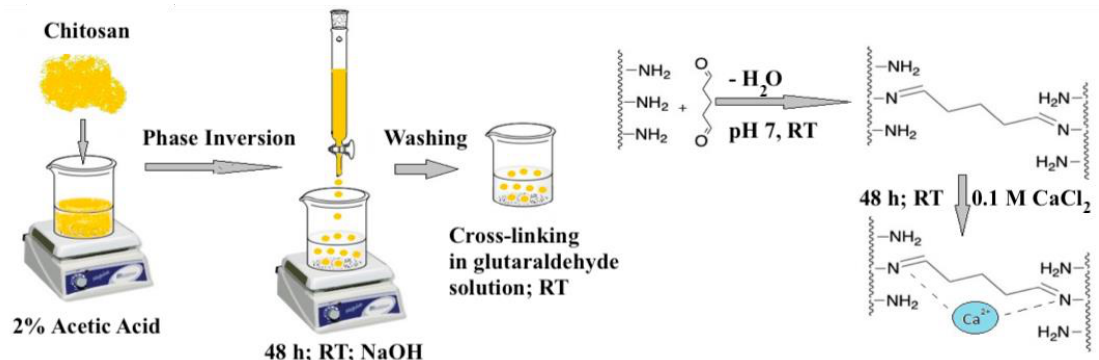
Figure 1. Schematic view of the synthesis of chitosan-derived beads under phase inversion synthesis with subsequent cross-linking via Schiff-base formation with glutaraldehyde and calcium-ion imbibing.